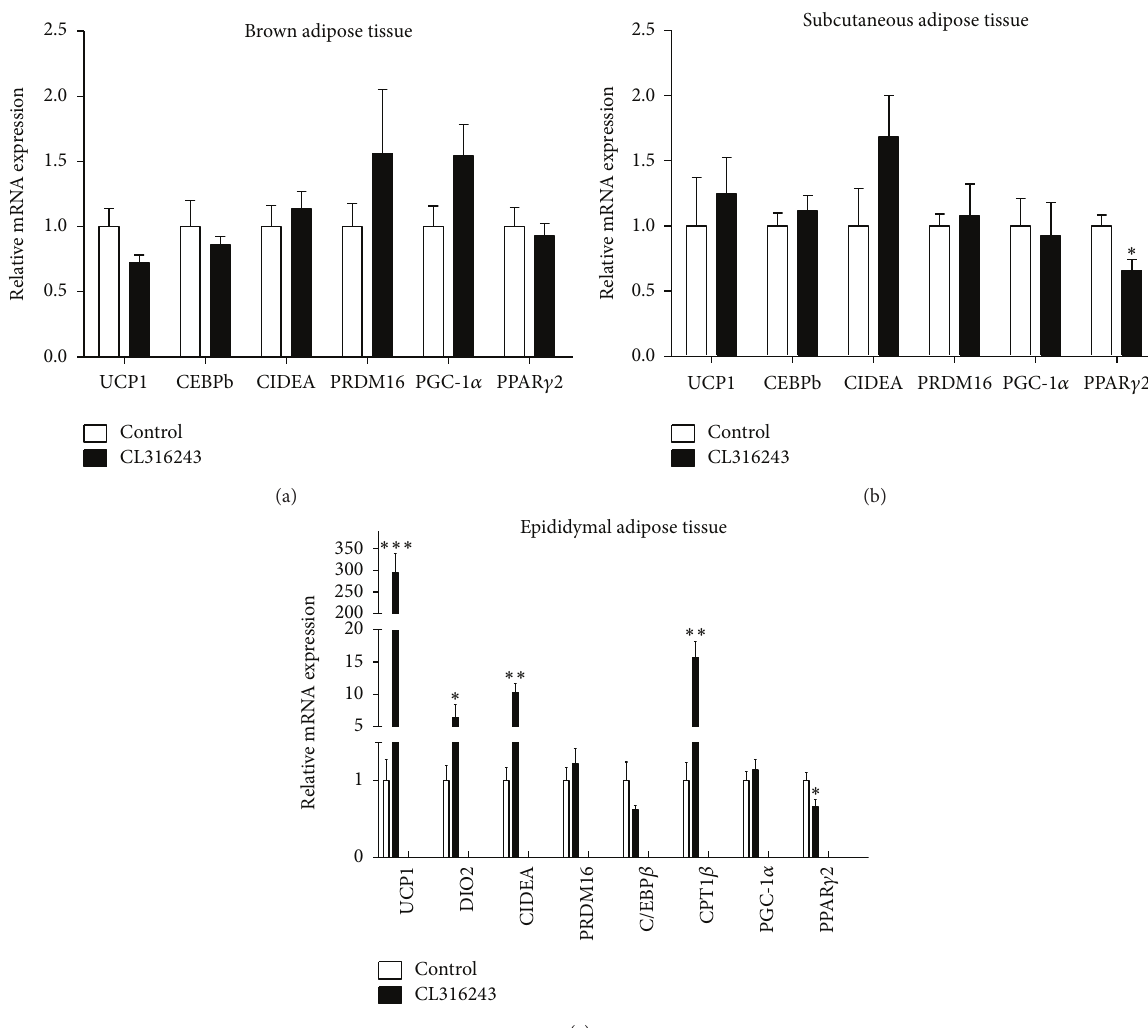
Figure 1: Analyses of mRNA expression of genes involved in WAT browning by qRT-PCR in brown adipose tissue, epididymal adipose tissue, and subcutaneous adipose tissue. (a) mRNA expression of genes involved in WAT browning in brown adipose tissue. (b) mRNA expression of genes involved in WAT browning in subcutaneous adipose tissue. (c) mRNA expression of genes involved in WAT browning in epididymal adipose tissue; 𝑛 = 7 each. Values are mean ± SEM; ∗ 𝑃 < 0.05 , ∗∗ 𝑃 < 0.01 , and ∗∗∗ 𝑃 < 0.001 .